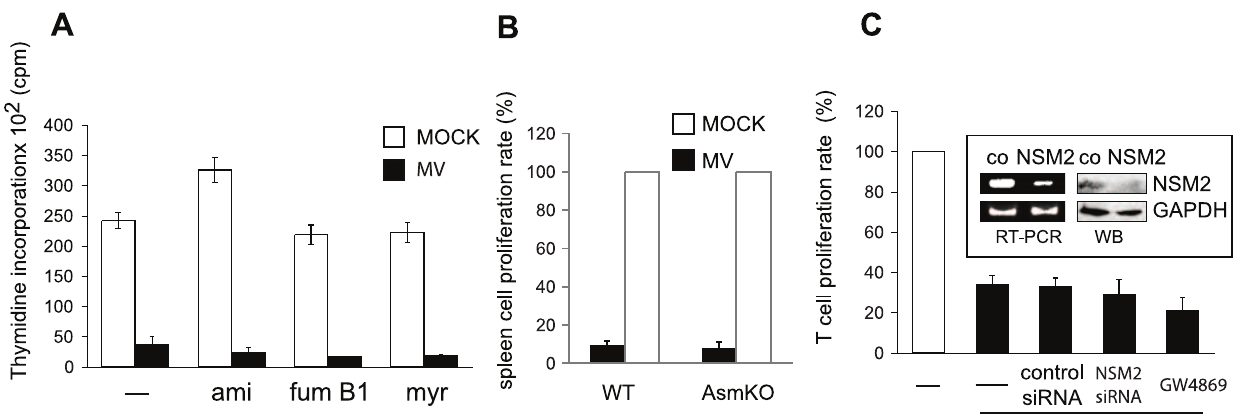
Figure 2. MV-induced SMase activation does not account for MV interference with stimulated T cell expansion. (A) Human primary T cells left untreated or treated with amitriptyline (ami), fumonisin B (Fum B1), myriocin (myr) for 2 hrs were exposed to MV or MOCK in the presence of FIP and a CD3/CD28 stimulated. Proliferation was monitored by 3 H-thymidine incorporation during the last 16 hrs of culture. One representative out of three independent experiments (each performed in triplicates) using three different donors is shown. (B) Spleen cells isolated from AsmKO or wild- type mice were exposed to MOCK or MV and a CD3/CD28 stimulated. Proliferation rates were determined as described in A, with those seen for the MOCK controls set to 100%. (C) Human primary T cells were either left untreated, or transfected with a scrambled (control siRNA) or a NSM2-specific siRNA (NSM2) or pretreated with the NSM-inhibitor (GW4869). 24 hrs after inhibitor treatment or 96 hrs after transfection, cells were exposed to MV (black bars) or MOCK (white bar), a CD3/CD28-stimulated and proliferation rates were determined as described in (A). Values obtained (in three independent experiments) for MOCK were each set to 100% and those obtained MV exposed samples (black bottom line) were determined as relative to the individual MOCK controls. The efficiency of NSM2 silencing by control or the specific siRNA was controlled by RT-PCR and WB